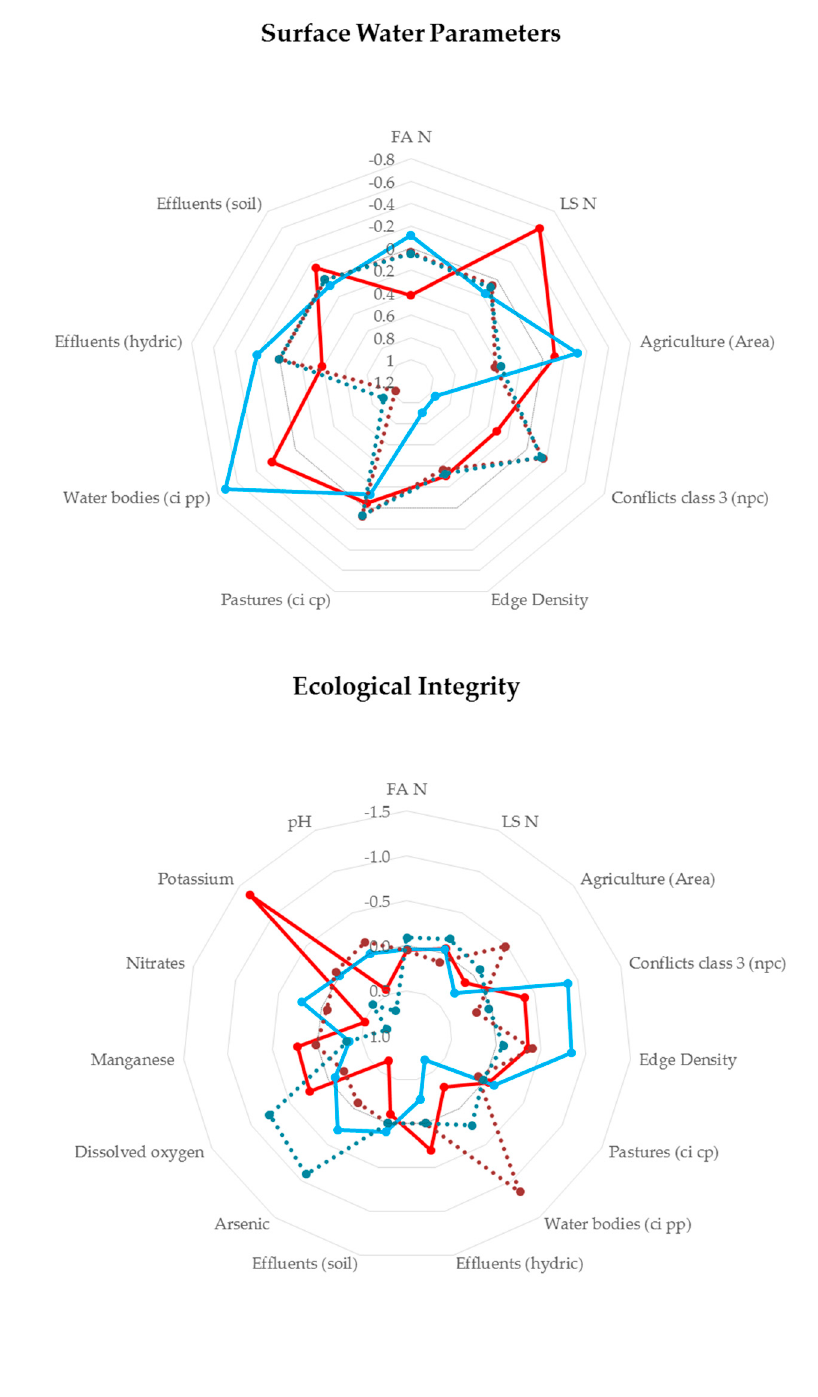
Figure 5. Contributions of the measured variables to the latent variables “SWP” and “Ecological integrity”, in summer and winter and on short and long spatial scales.